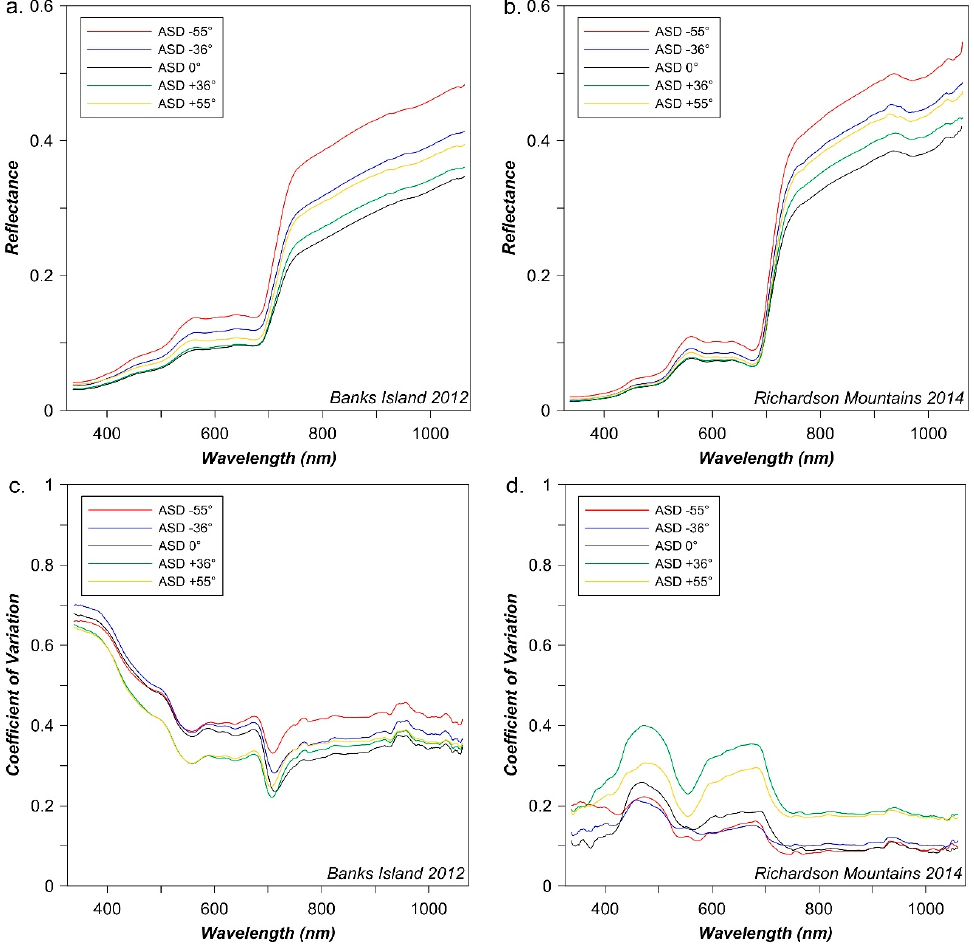
Figure 5. Averaged field spectra ( a ) and coefficient of variation ( c ) from the Banks Island 2012 site and the Richardson Mountains 2014 site (( b ) and ( d ), respectively). For the Banks Island site, each of the multi-angle spectra was averaged from ~3465 individual spectral measurements, whereas each of the multi-angle spectra for the Richardson Mountains site was averaged from ~1890 individual spectral measurements. Additional spectra showing intermediate conditions can be found in Kennedy [91].